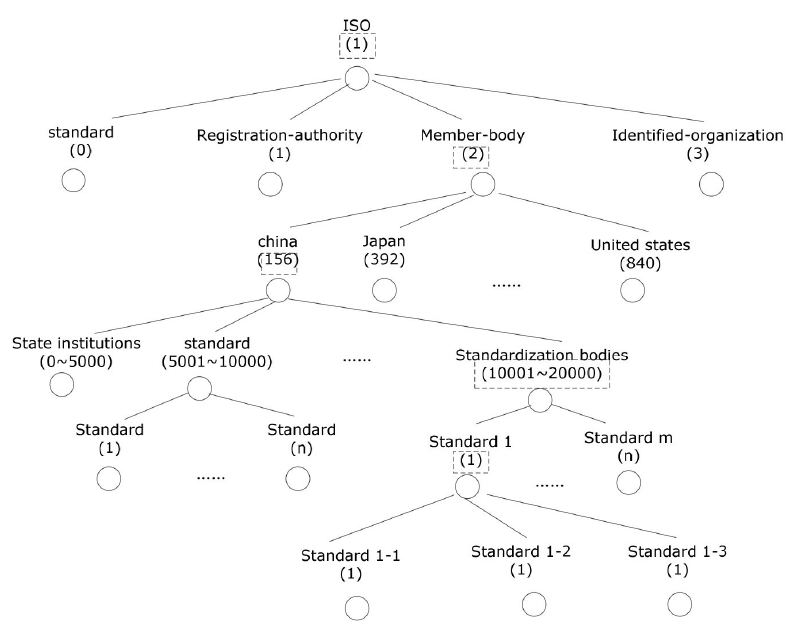
Figure 2. Application Example of Standard Identification Code